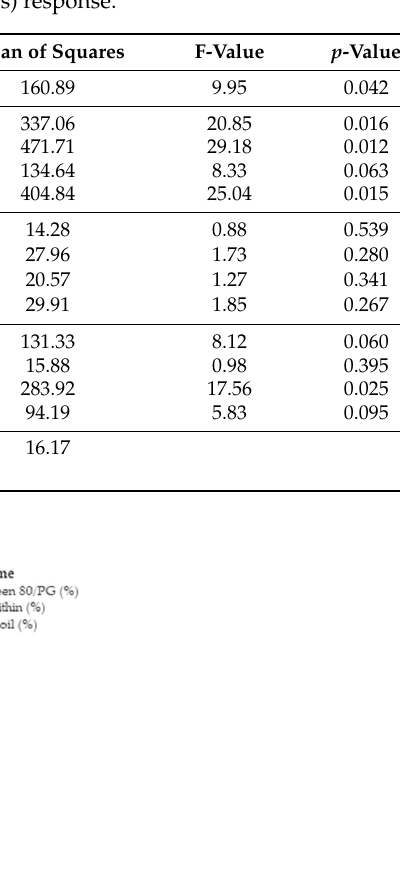
Table 10. Analysis of variance for mean droplet size (Ds) response.